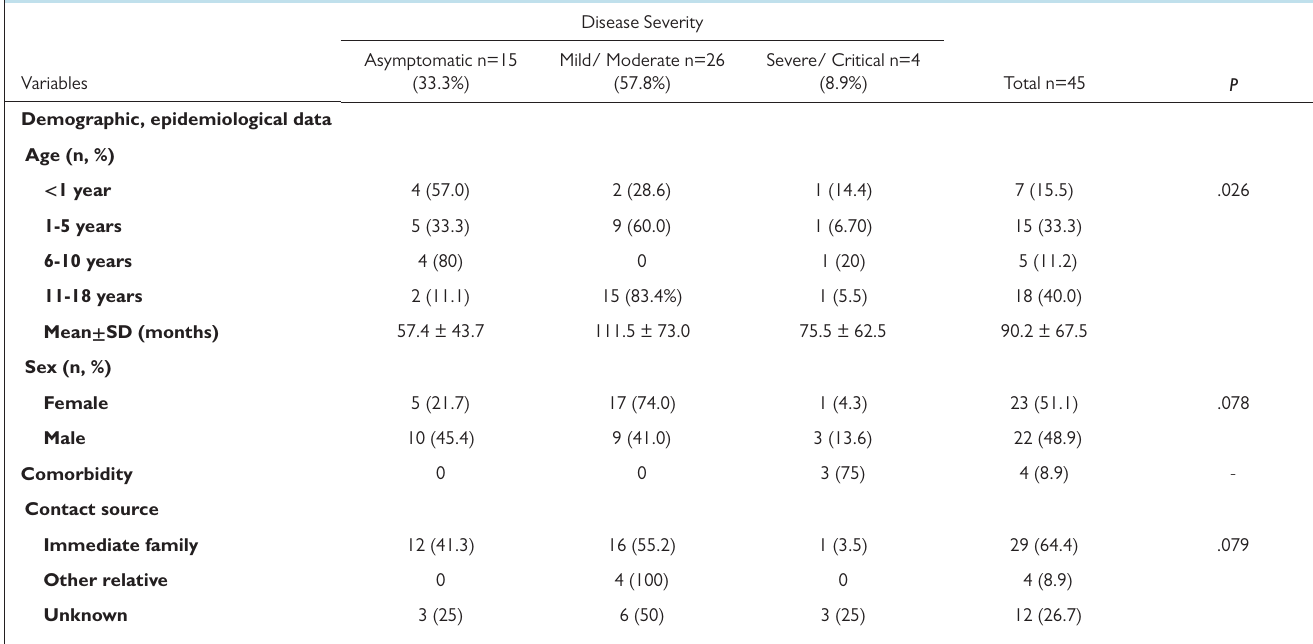
Disease Severity